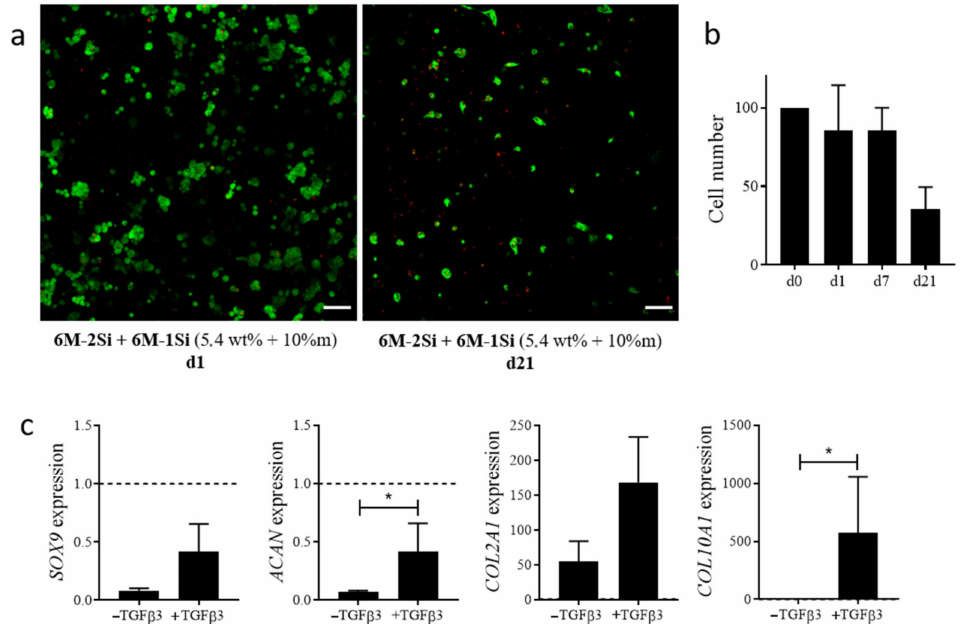
Figure 9. ( a ) Cell viability of hMSCs measured by the LIVE/DEAD assay in 6M-2Si / 6M-1Si hydro- gels after 1 and 21 days of encapsulation. Images are the maximum intensity z-projection. Scale bar is 100 µ m. ( b ) Number of hMSCs measured by DNA quantification in a 6M-2Si / 6M-1Si hydrogel at day 0, 1, 7 and 21 days after encapsulation. Data are expressed as the mean ± SEM of four inde- pendent experiments and normalized to 100% at day 0. ( c ) Chondrocyte gene expression in hMSCs encapsulated in 6M-2Si / 6M-1Si hydrogels after 21 days of differentiation. Data are expressed as the mean ± SEM of three independent experiments and expressed in a fold change compared with undifferentiated hMSCs at day 0 (dotted line). Statistical analyses were performed using GraphPad prism 9 software with the non-parametric Mann-Whitney test to compare the two conditions. Values are statistically different when p < 0.05 (* p <